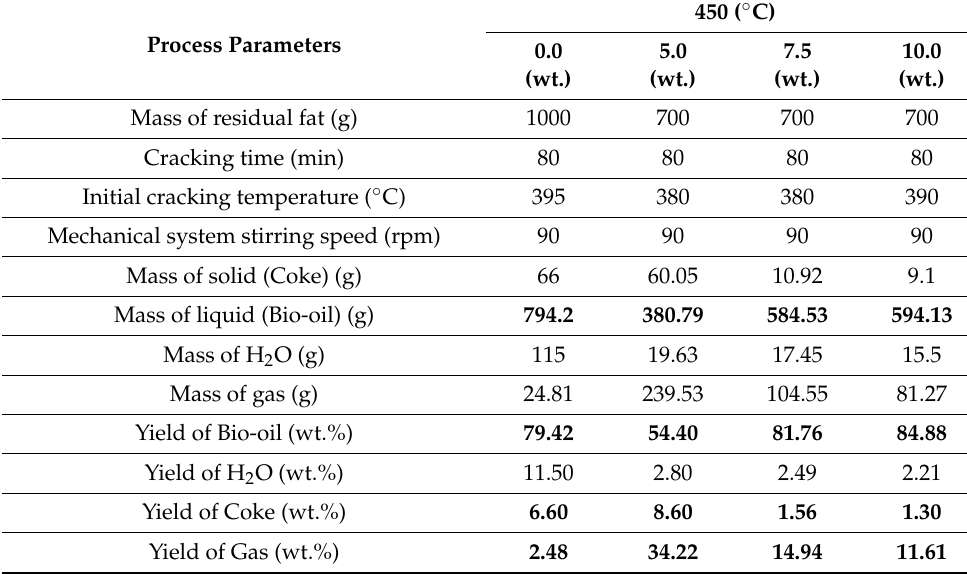
Table 3. Process parameters, mass balances, and yields of reaction products (liquids, solids, H 2 O, and